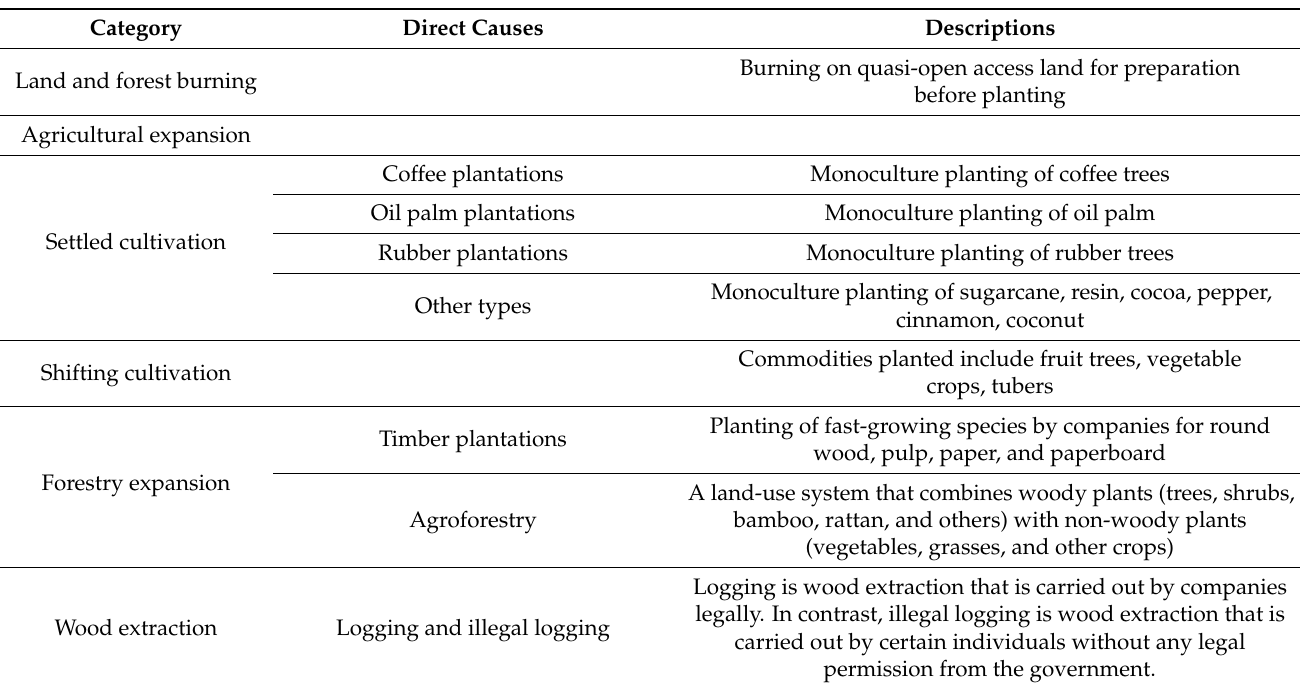
Table A3. Direct causes of land change in Sumatra and Kalimantan.